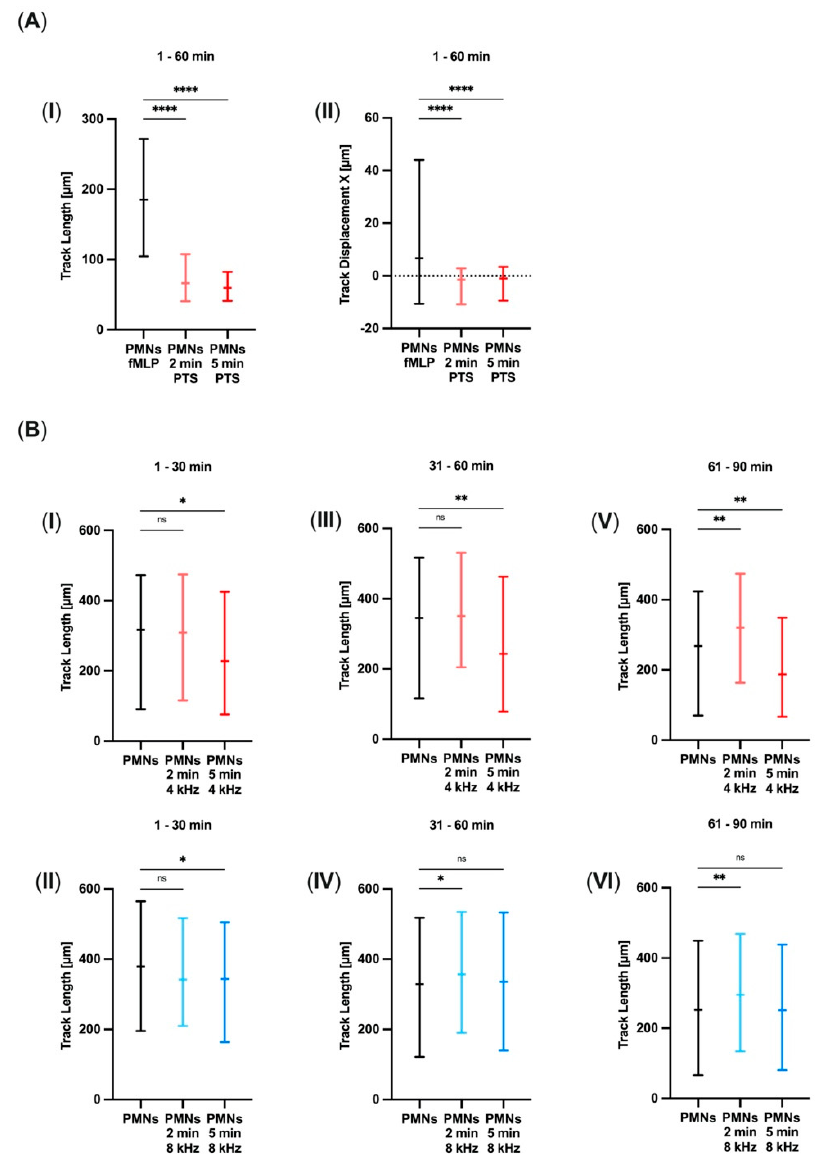
Figure 1. Modified migration of CAP-treated PMNs without any chemo-attractive PTS effect. ( A , I , II ) Track Length and Track Displacement X [ µ m] of PMNs towards either the chemo-attractant fMLP or 2 min or 5 min plasma-treated solution (PTS) during Observation Minutes 1–60 ( n = 5; mean number of tracks = 882). ( B , I – VI ) Track Length [ µ m] of PMNs after CAP treatment with 4 kHz ( n = 6; mean number of tracks = 387) or 8 kHz ( n = 5; mean number of tracks = 814) for 2 min and 5 min in 30-minute observation periods from Minute 1 to 90. Migration was quantified by semiautomated cell tracking during live cell imaging. Statistical analysis: Kruskal–Wallis test. * p < 0.05, ** p < 0.01, **** p < 0.0001, ns: not significant.